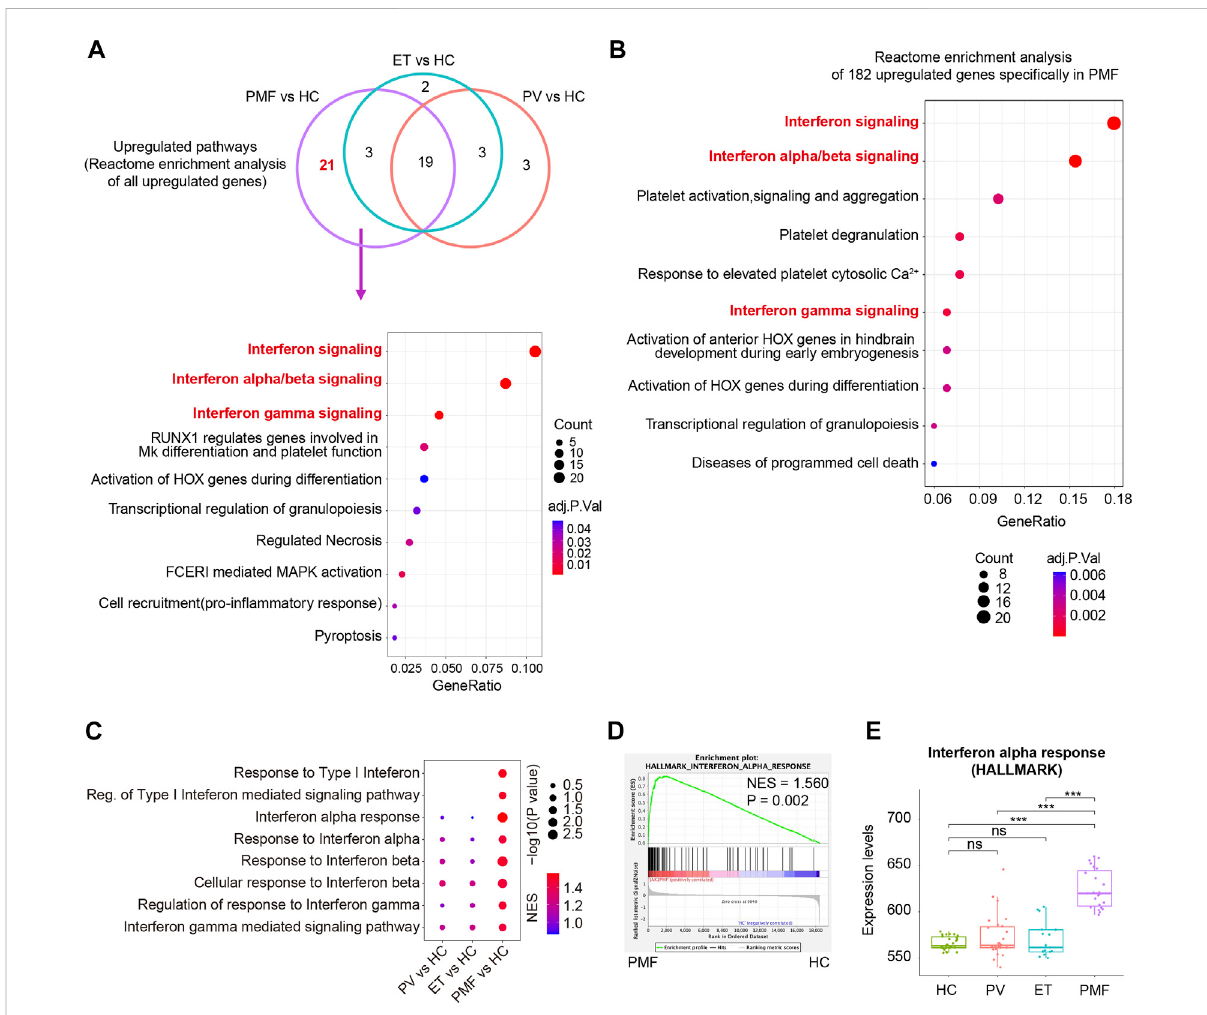
FIGURE 6 (A) Venn diagram of enriched Reactome pathways of upregulated genes in each MPN subtype compared to HC. Some of the 21 enriched Reactome pathways uniquely in JAK2V617F + PMF were shown in the dot plot. The size of the dots represents the number of genes. The color of the dots denotes the adjusted p value. (B) Top 10 enriched Reactome pathways of 182 upregulated genes uniquely in JAK2V617F + PMF were shown in the dot plot. The size of the dots represents the number of genes. The color of the dots denotes the adjusted p value. (C) Gene set enrichment analysis (GSEA) of the Interferon-related signaling pathways between each MPN subtype and HC. The size of the dots represents − log10 (NOM p value). The color of the dots denotes the NES. (D) GSEA of the gene set “